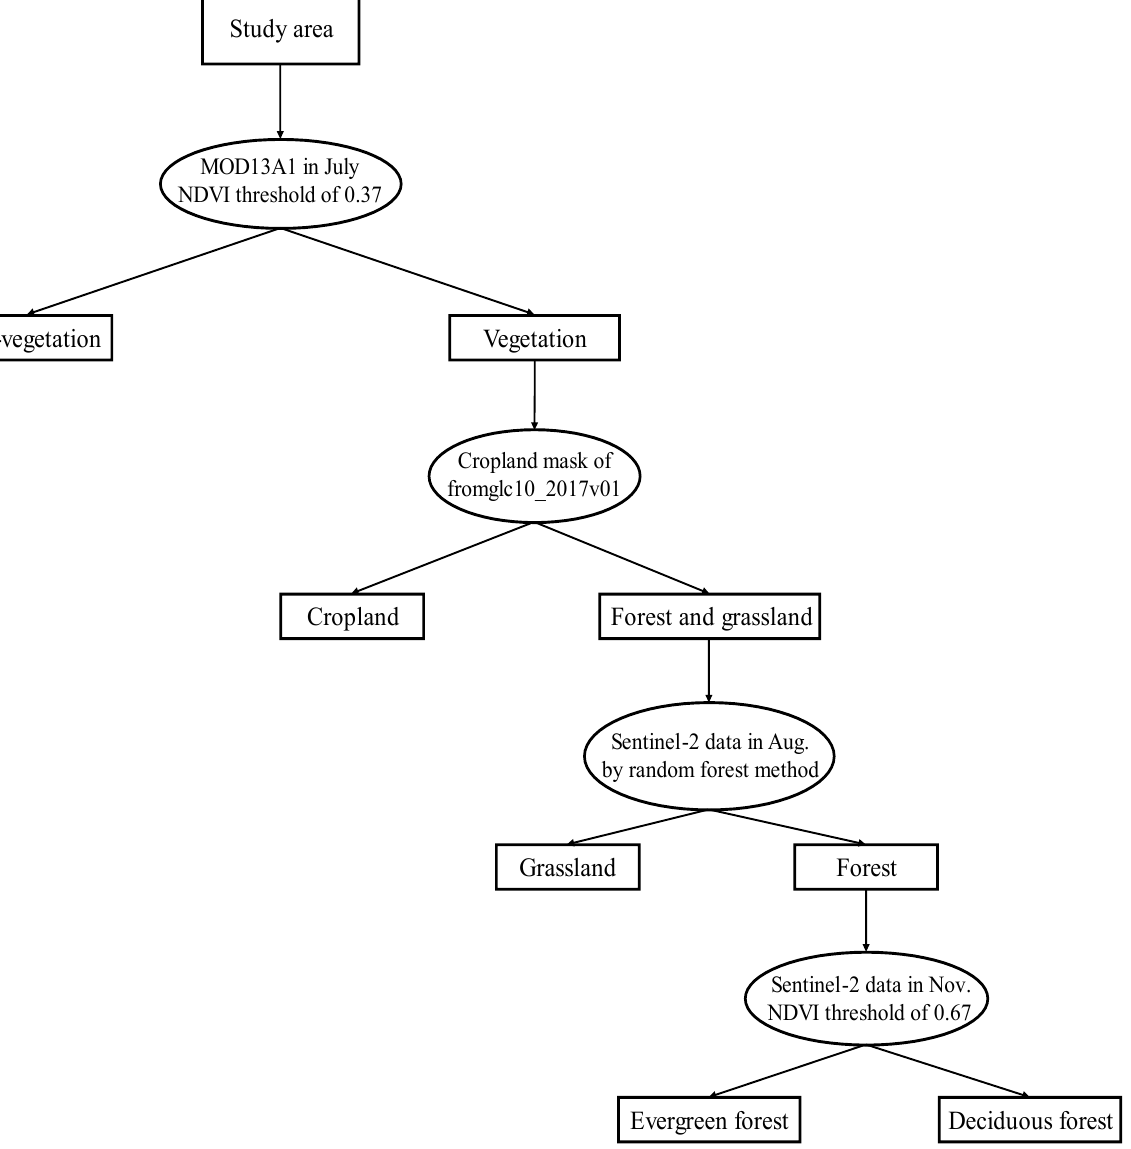
Figure A3. Process diagram of vegetation classification.